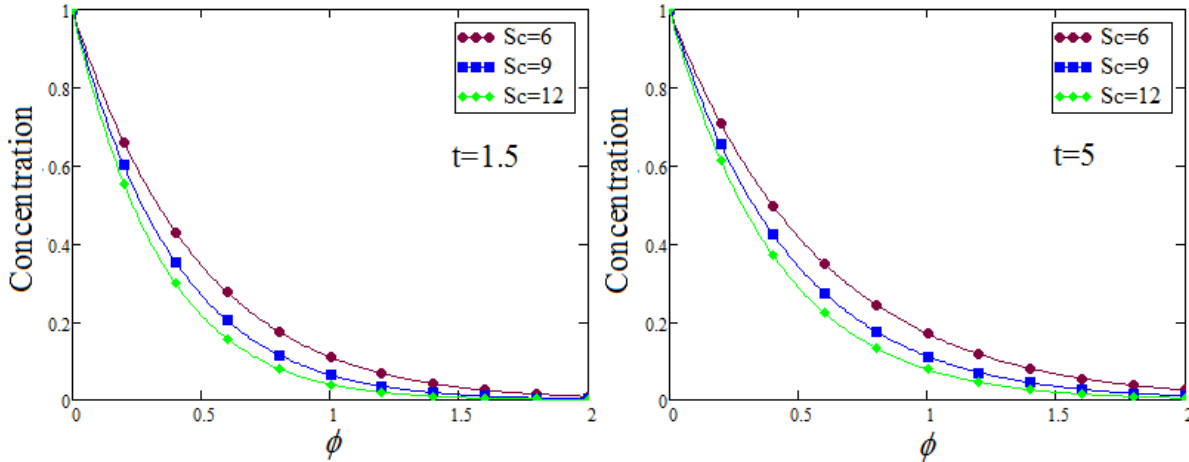
Figure 9. Graphical representations of concentration profile by taking distinct values of Sc at two different levels of time, when α = 0.5, ℘ = 0.4, β = 0.3, and γ = 0.5.